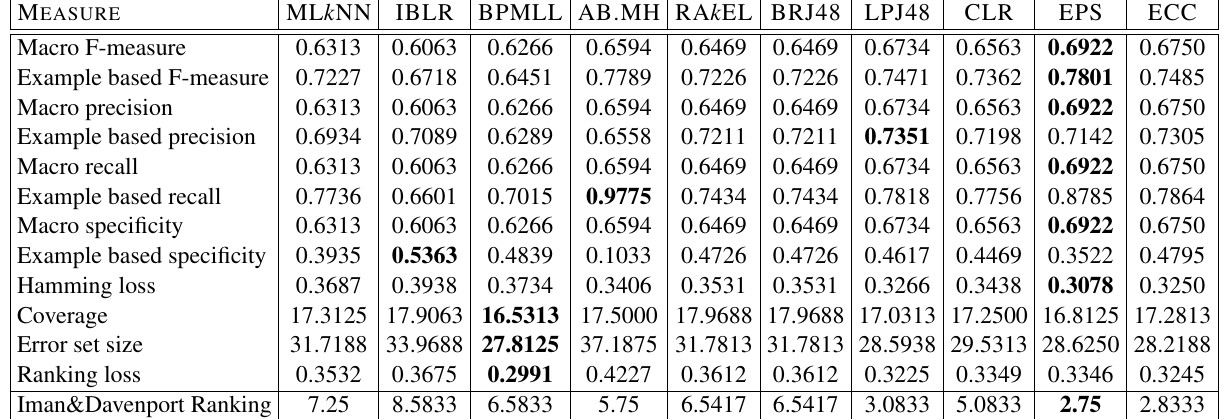
Table 9: Multi-label classification